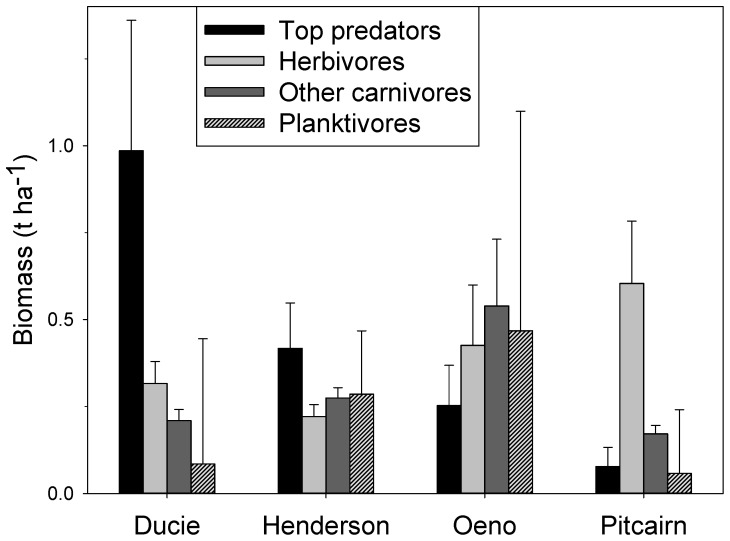
Biomass (t ha−1) of reef fishes by trophic group at each island of the Pitcairn islands.Error bars are standard error of the mean.